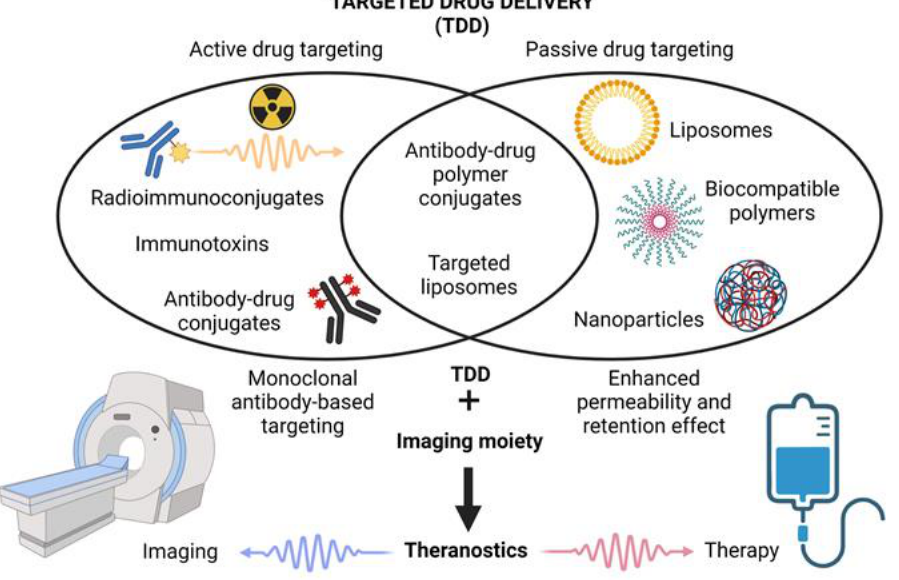
Figure 1. Targeted drug delivery systems and theranostics (Created with BioRender 20 / 12 /